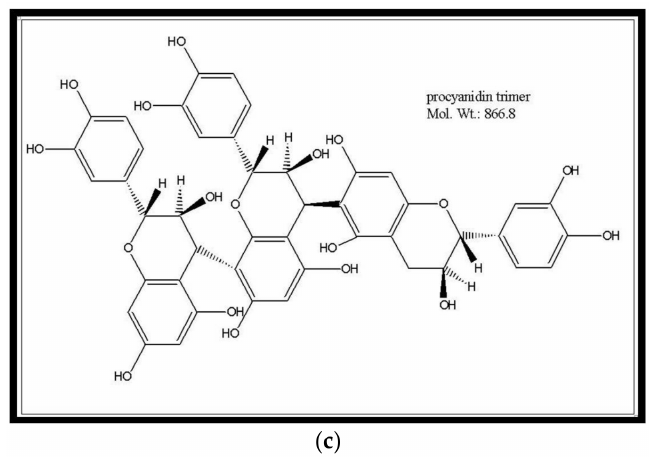
Figure 1. Examples of ( a ) simple and ( b , c ) complex polyphenols in